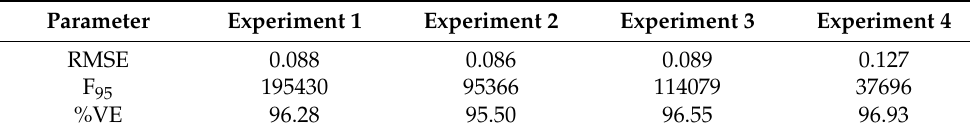
Table 5. Statistical parameters of proposed kinetic